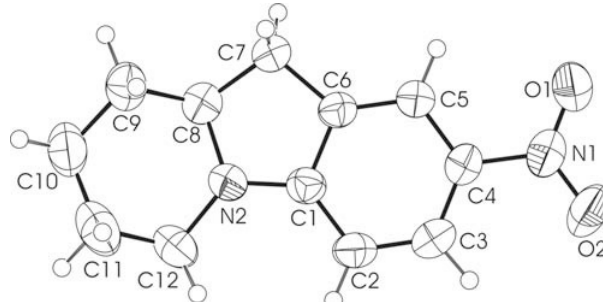
Table 1. Data collection and handling.